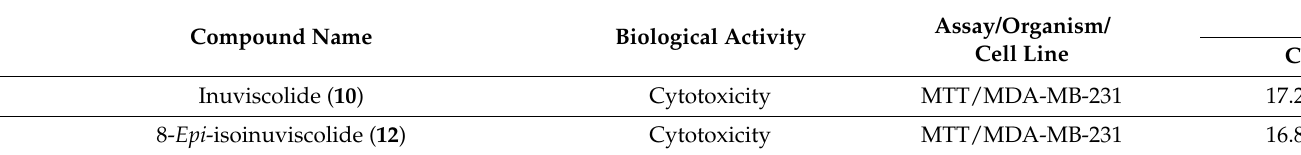
Table 2. Biological activity of reported metabolites from Carpesium abrotanoides